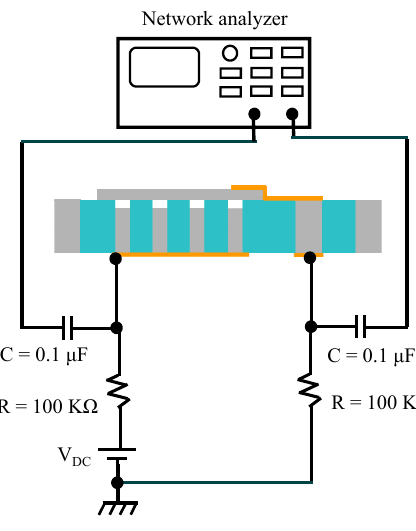
Figure 6. Measurement setup.